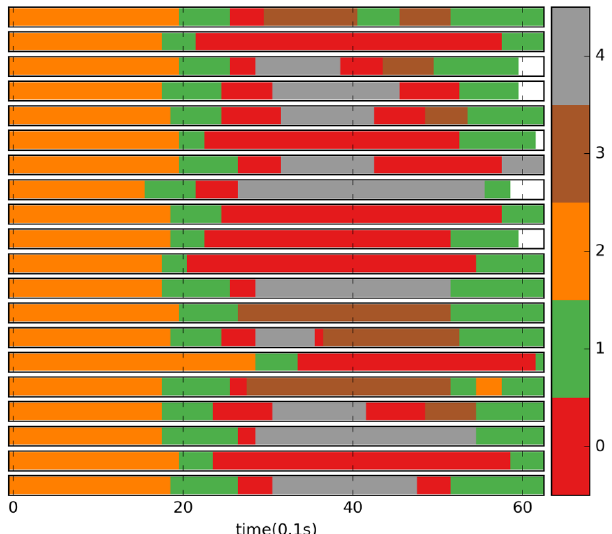
Figure 7. Illustration of the hidden-state representation of Skill 3 when the truncation states number is set to K = 5. Each row represents the learned hidden-state sequence of a nominal trial. Each color represents a different hidden state. White color indicates a shorter skill